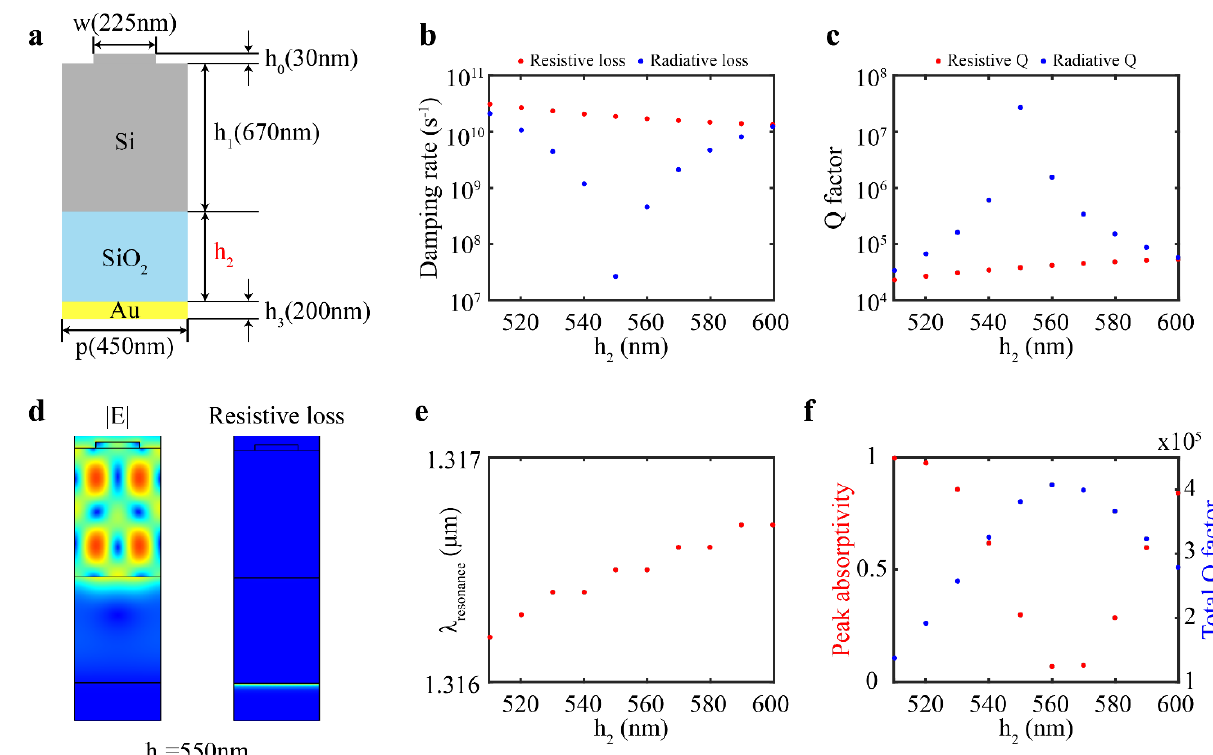
Figure 3. Analysis of Q factor and peak absorptivity. ( a ) Schematic of the simulated structure. The only variable parameter is the SiO 2 layer thickness h 2 . Plots of ( b ) damping rates and ( c ) Q factors versus h 2 . Red and blue dots represent resistive and radiative losses, respectively. ( d ) Distribution of electric field (left) and resistive loss (right) for h 2 = 550 nm. ( e ) The resonant wavelength versus h 2 plots. ( f ) Peak absorptivity (red dots) and total Q factor (blue dots) versus h 2 plots. For all the above cases, h 2 is tuned from 510 nm to 610 nm, with an interval of 10